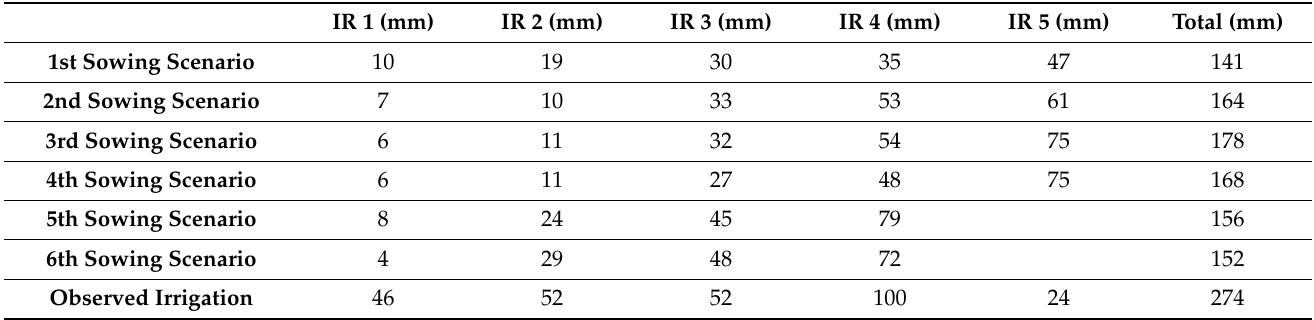
Figure 12. Comparison of the variation of irrigation amount (mm), between simulated scenarios and the real case (observed irrigation at the 2011–2012 agricultural season). The statistical Student’s t -test shows that there are two groups of scenarios (S1, S5 and S6) and (S2, S3 and S4) at p > 0.05. Table 4. Irrigation water demands (mm) estimated for each irrigation round (IR) compared to the applied irrigations at the 2011–2012 agricultural